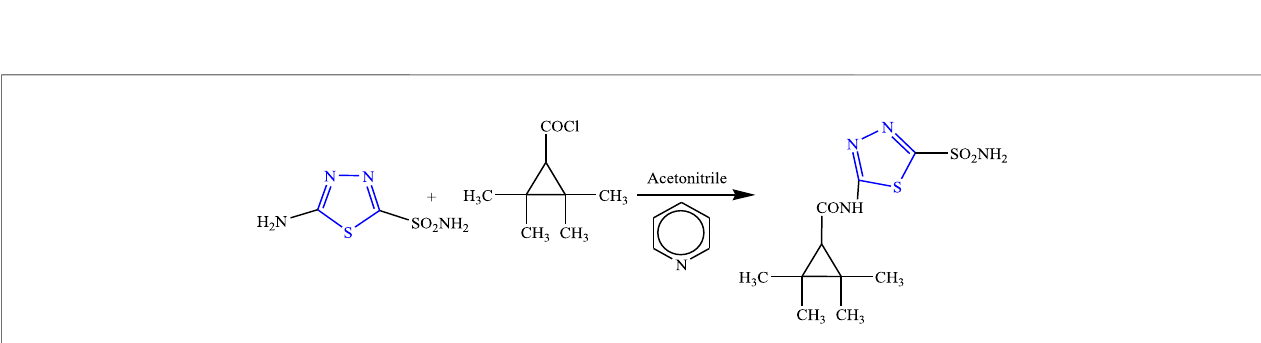
FIGURE 30 | Synthetic pathway for synthesizing new 1,3,4-thiadiazole-2-sulfonamide derivatives.